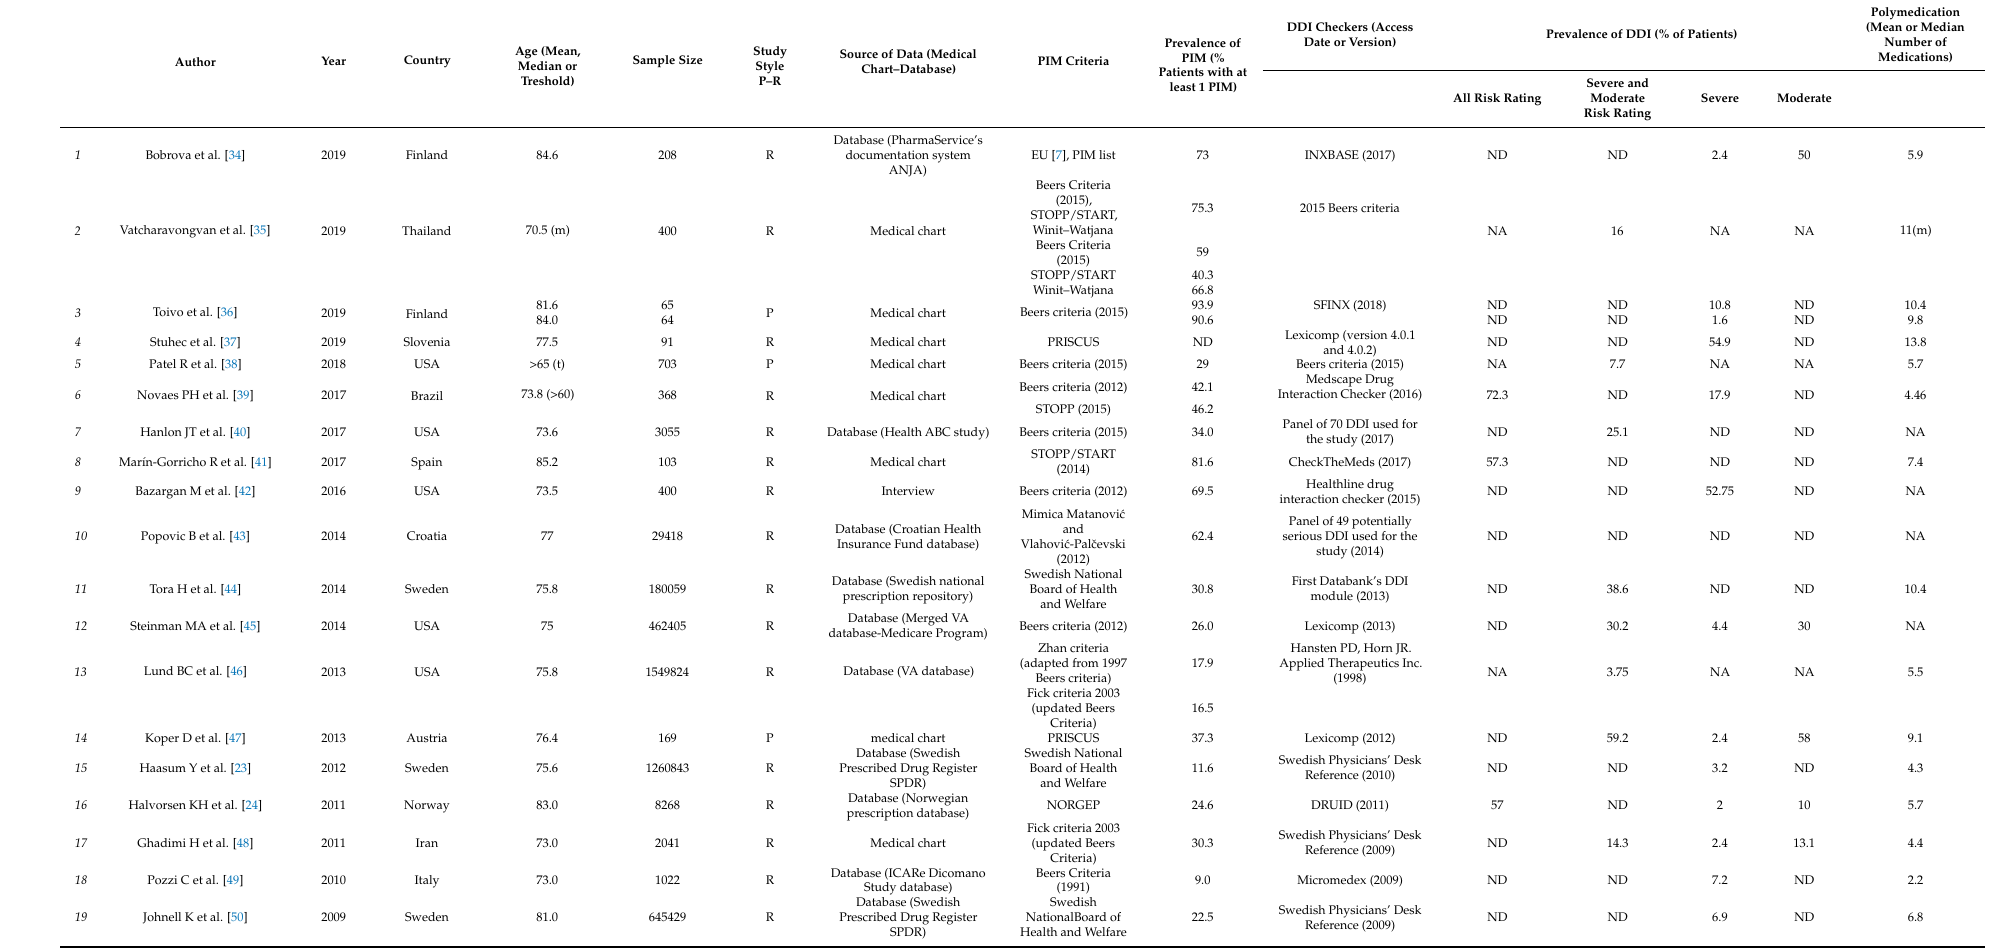
Table 2. Prevalence (%) of PIM and DDI (total, severe and moderate) and polymedication (mean or median) in elderly patients primary care setting. At the end of the table, the prevalence of PIM and of DDI is reported as the weighted mean (in bold). Footnote: Prospective (P), retrospective (R), mean (M), median (m), threshold (t), severe (S), moderate (M), not apply (NA), not determined